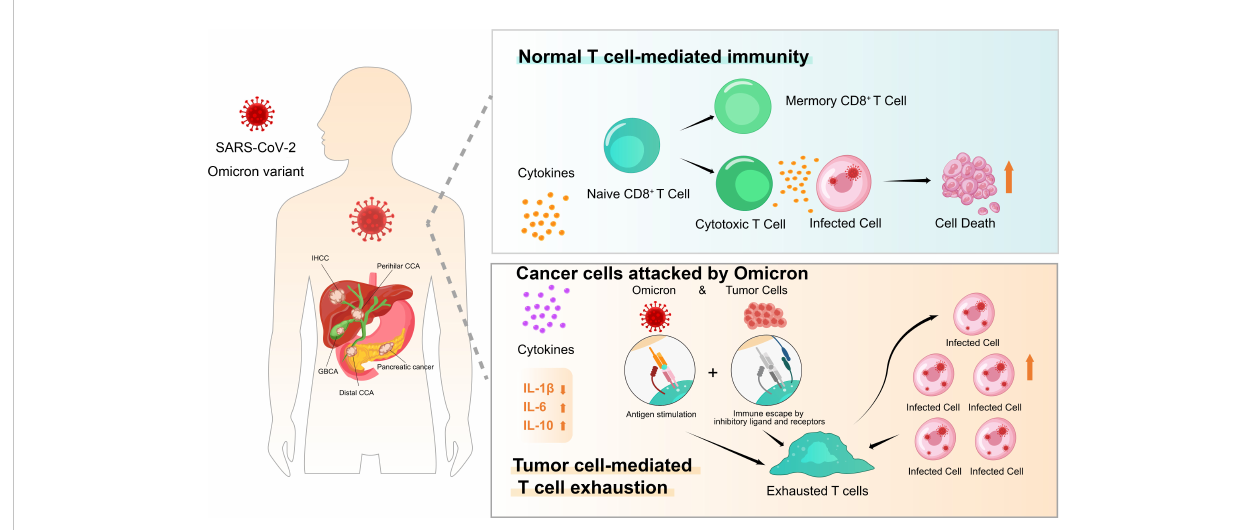
FIGURE 8 Patients with pancreatic and biliary cancer appeared vulnerable and have severe outcomes to Omicron outbreak in presentation with T-cell exhaustion and immunode fi ciency. The effects of normal T-cell-mediated immunity and tumor cell-mediated T-cell exhaustion after Omicron attacks tumor cells on tumor patients are